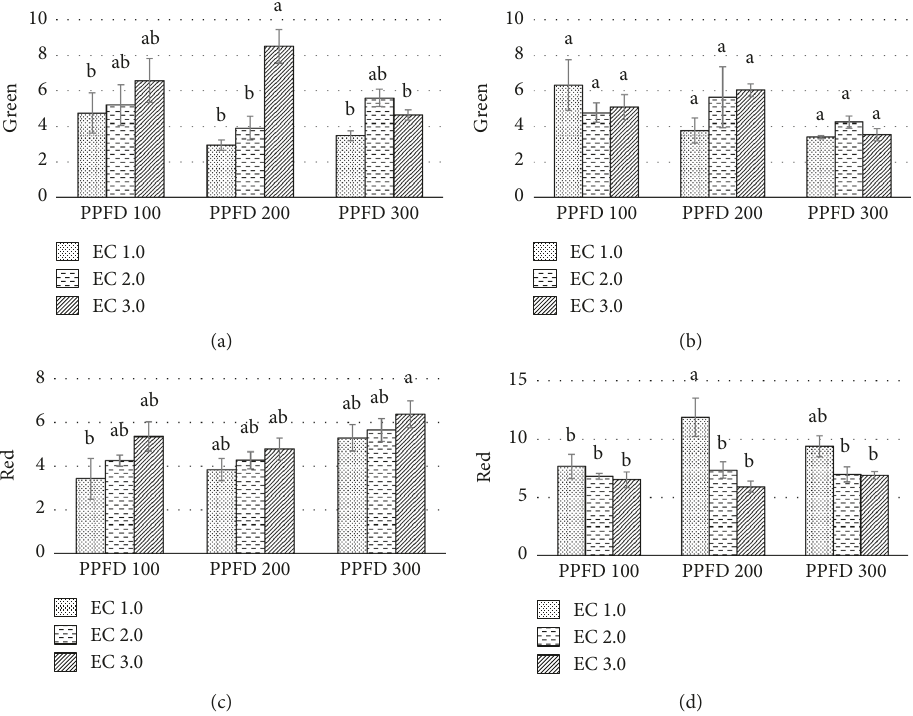
Figure 1: Content per unit of leaf dry weight ( µ g · g − 1 ) in perilla plants after 5 weeks of cultivation under different LI and EC treatments. (a) AG content per leaf dry weight ( µ g · g − 1 ) in green; (b) LT content per leaf dry weight ( µ g · g − 1 ) in green; (c) AG content per leaf dry weight ( µ g · g − 1 ) in red; (d) LT content per leaf dry weight ( µ g · g − 1 ) in red. Values are mean ± standard error ( n � 5 − 6). Different letters indicate significant differences between at P < 0 . 05, as determined by Tukey’s